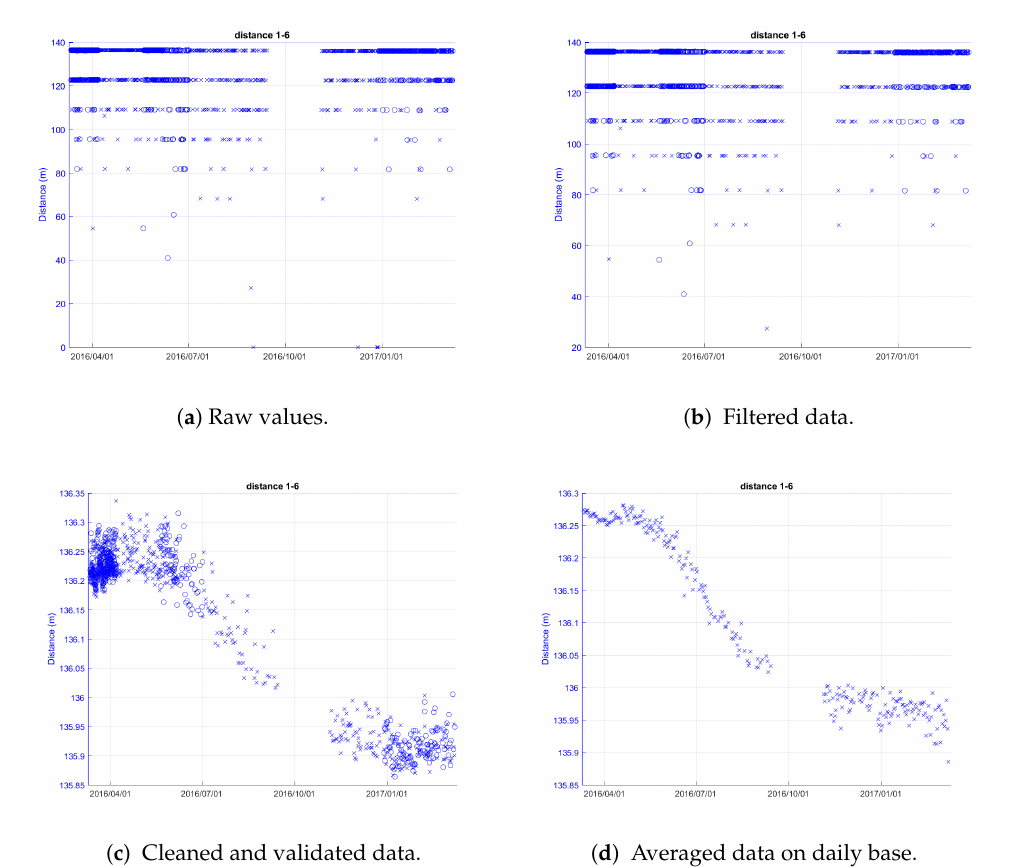
Figure 8. Processing stages on data of distance between nodes 1 and 6 measured by the ultra wideband (UWB) technology over one year (Cluster